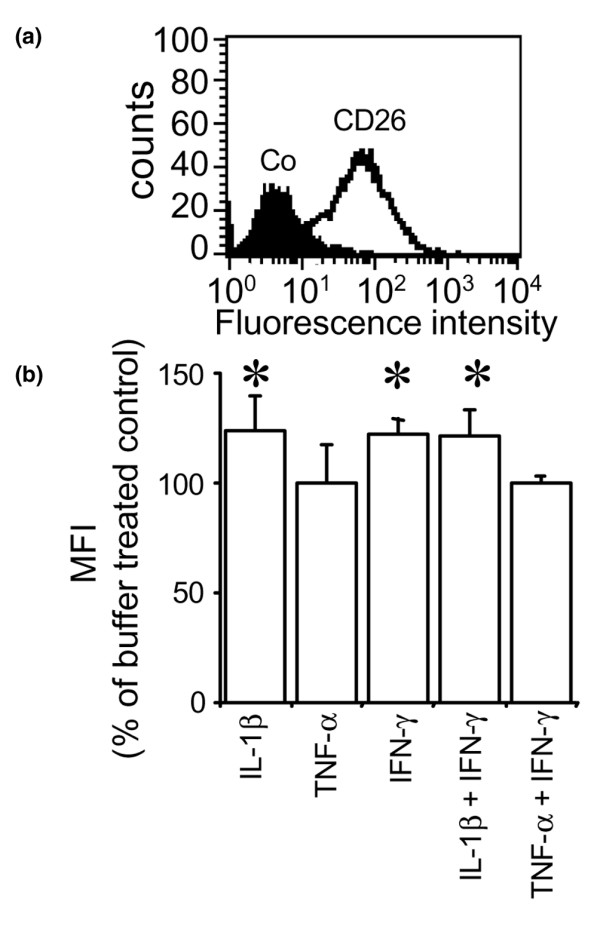
Detection of CD26 by Fluorescence-activated cell sorting (FACS) analysis. Expression of CD26 was detected by FACS analysis. (a) Expression level of CD26 on unstimulated fibroblasts. Background staining with secondary antibody only (black histograms) was compared with specific CD26-staining (open histograms). Control staining with isotype antibodies resulted in a similar histogram as with secondary antibody alone. Confluent fibroblast monolayers were left untreated (Co) or were treated with IL-1β (100 U/ml), tumour necrosis factor alpha (TNF-α) (10 ng/ml), IFN-γ (200 ng/ml) or with combinations of these cytokines. (b) Regulation of CD26 expression as the percentage of the relative mean fluorescence intensity (MFI) for untreated fibroblasts (± standard error of the mean). The mean MFI of four experiments is shown (except for treatment with IFN-γ alone, for which n = 3). Statistical analysis was performed with the Mann–Whitney U test, *P < 0.05.